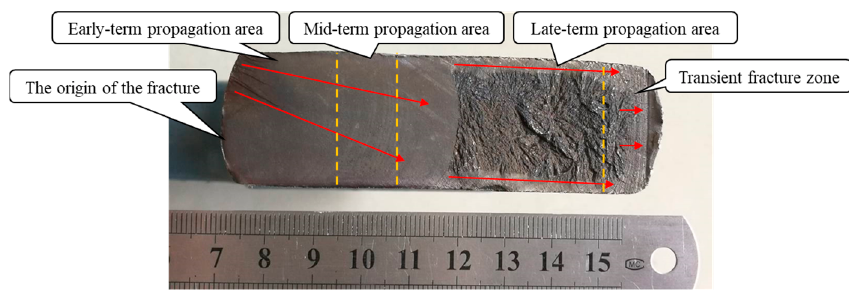
Figure 2. Macroscopic view of boom fracture (Unit: mm).